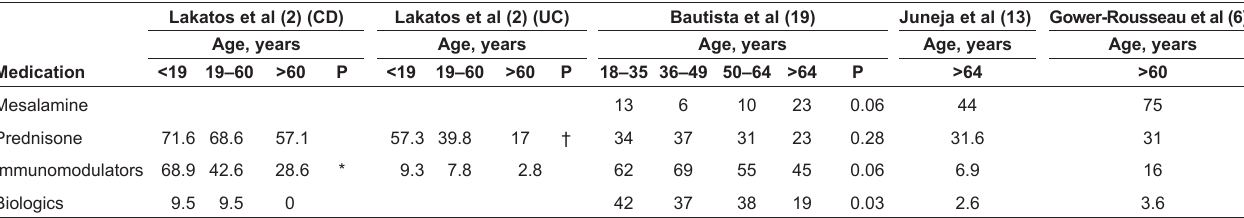
Table 5 Medication usage in elderly inflammatory bowel disease patients